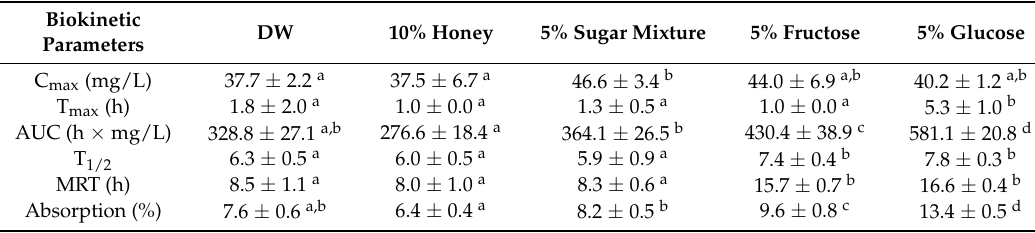
Figure 11. Plasma concentration-time profiles of ZnO NPs suspended in DW or different saccharide solutions after single oral administration to rats. Different lower-case letters (a–c) indicate significant differences between DW and saccharide solutions ( p < 0.05). Table 1. Biokinetic parameters and oral absorption of ZnO NPs suspended in different saccharide solutions after single oral administration to rats.